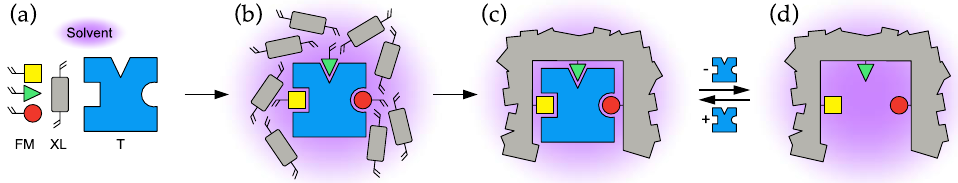
Figure 1. Schematic description of the different stages in the molecular imprinting process. ( a ) The main polymer components: template (T), functional monomers (FM) and cross-linking monomer (XL). ( b ) Pre-polymerization mixture, ( c ) after polymerization, ( d ) after template removal. Consequently, the molecular and physical characteristics of recognition sites in MIPs result directly from the various interactions possible in the pre-polymerization